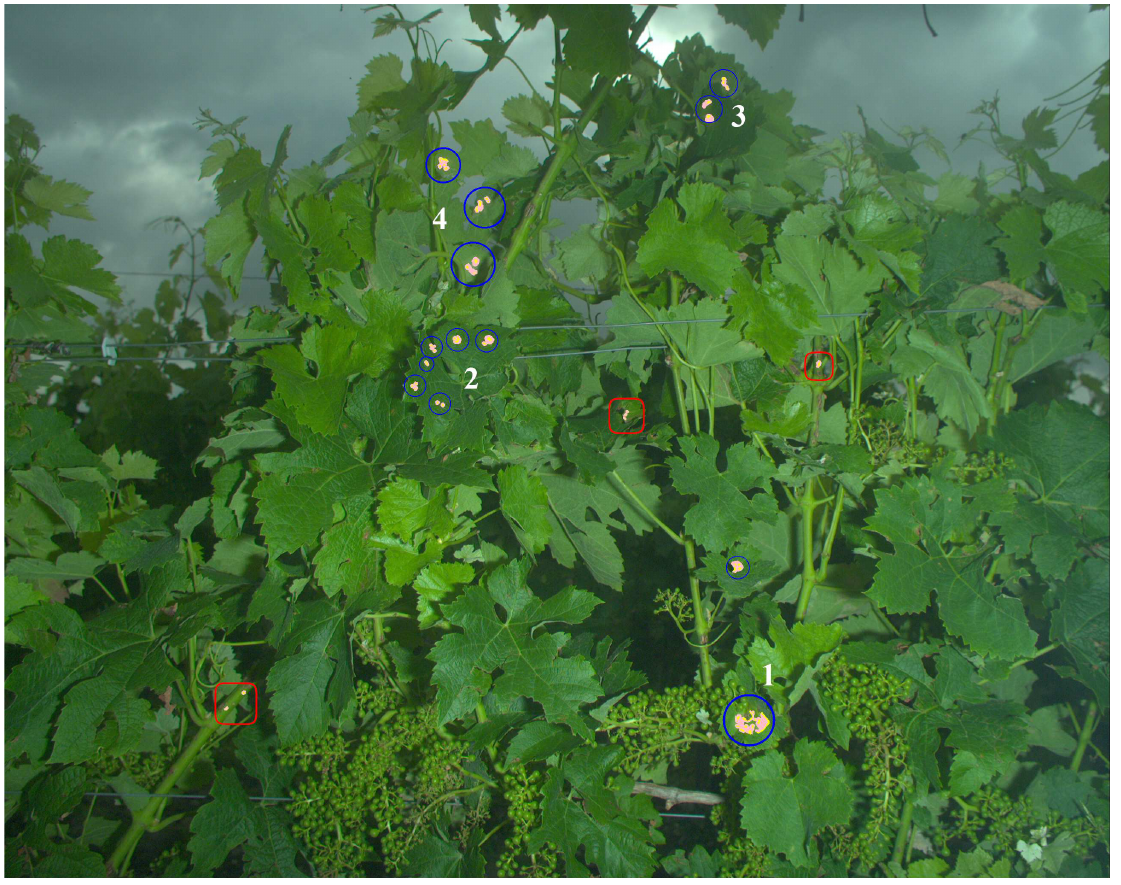
Figure 11. Reconstruction results with the thresholds: (seeds) [ R min = 2.5, α = 0.1 ] (cid:55)−→ [ R min = 1, α = 0.2] (expansion). Blue circles indicate the seeds corresponding to annotated symptoms. Red frames indicate false